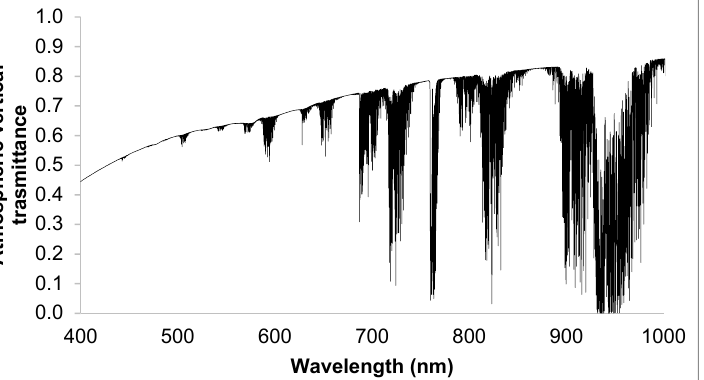
illumination effects and observed without the presence of the atmosphere. As a conse-